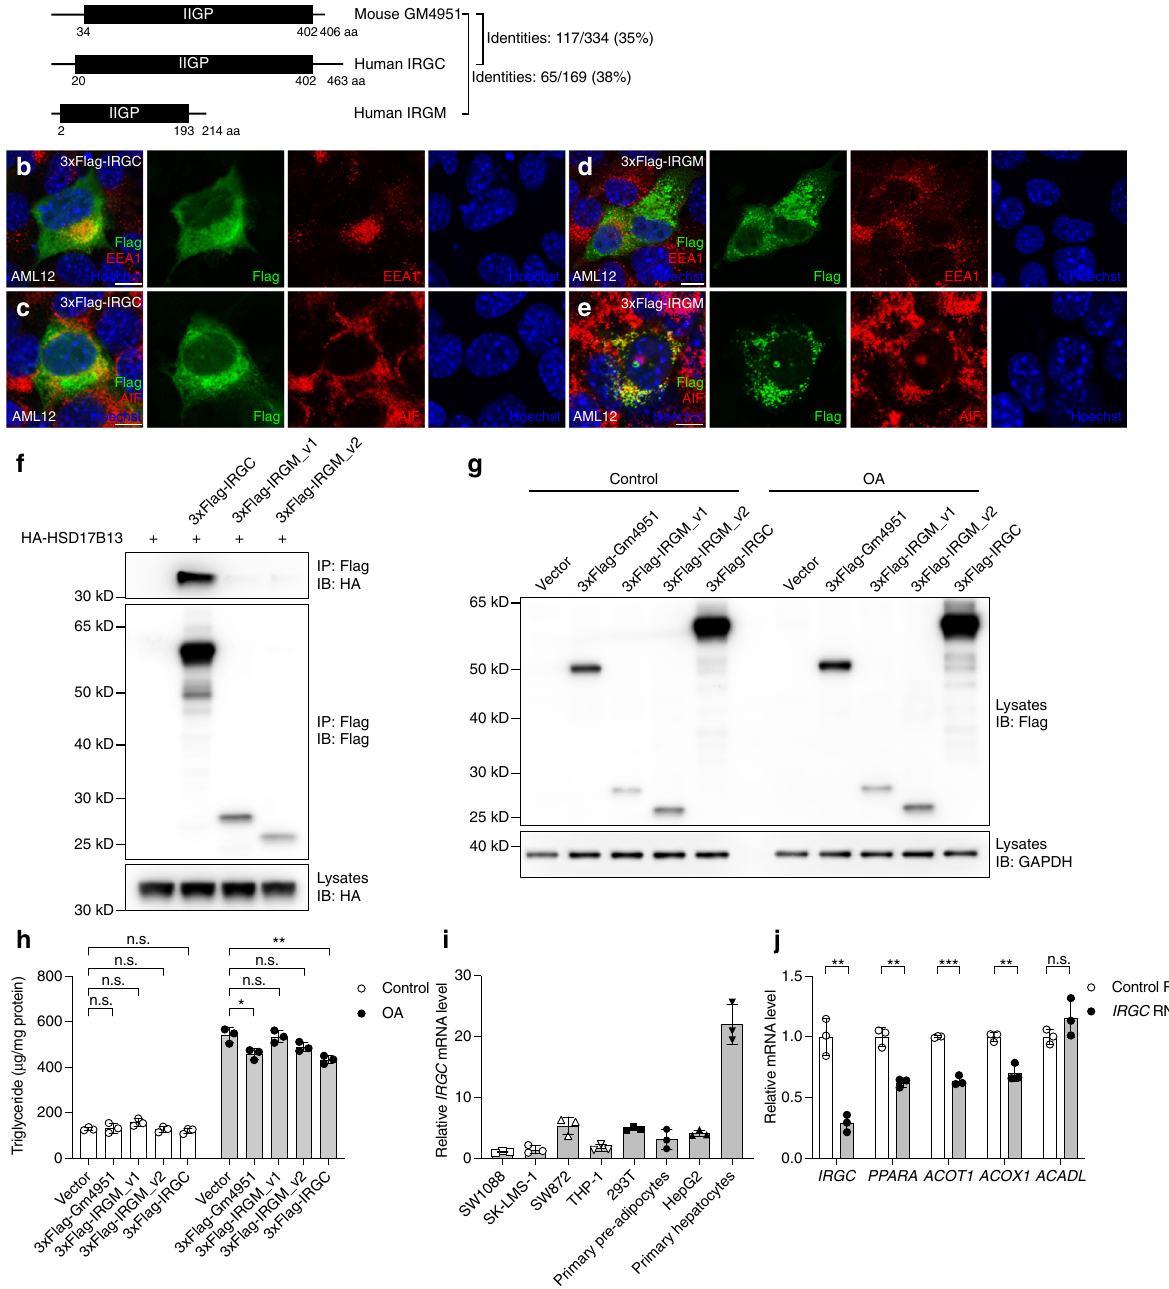
Fig. 8 Identi fi cation of potential human homologs of mouse GM4951. a Protein domain diagrams of mouse GM4951 and human IRGC and IRGM. Locations of IIGP domains and amino acid identities across the full length of the proteins are indicated. b – e AML12 cells expressing 3xFlag-tagged IRGC or IRGM were immunostained with Flag antibody (green), Hoechst 33342 (blue) to visualize nuclei, and organelle markers (red): AIF (mitochondria) and EEA1 (endosome). (Scale bar: 10 μ m.) f Immunoblots of immunoprecipitates (top and middle) or lysates (bottom) of 293T cells expressing HA-tagged human HSD17B13 and 3xFlag-tagged human IRGC, IRGM_v1, and IRGM_v2. g , h Immunoblots of lysates ( g ) or triglyceride level in lysates ( n = 3 cultures per group) ( h ) of primary human hepatocytes expressing different IRG genes with or without 0.5 mM OA treatment for 24 h. i Relative mRNA level of IRGC from different human cell lines or human primary cells. Levels were normalized to ACTB mRNA and then to levels in SW1088 cells ( n = 3 cultures per group). j Relative mRNA level of IRGC and several lipid oxidation genes ( PPARA , ACOT1 , ACOX1 , and ACADL ) from primary human hepatocytes transfected with control siRNA or IRGC siRNA with 0.5 mM OA treatment for 24 h ( n = 3 cultures per group). Levels were normalized to ACTB mRNA and then to levels in control RNAi. Data points represent independent cultures. Data are presented as means ± SD. P values were determined by one-way ANOVA with Tukey ’ s multiple comparison test ( h ) or two-tailed Student ’ s t test ( j ). P values are denoted by * P < 0.05; ** P < 0.01; *** P < 0.001; ns, not signi fi cant with P > 0.05. The exact P values of statistically signi fi cant groups are: 0.0158 ( h , Vector vs 3xFlag-Gm4951 OA); 0.0026 ( h , Vector vs 3xFlag-IRGC); 0.0019 ( j , IRGC ); 0.0015 ( j , PPARA ); 0.0001 ( j , ACOT1 ); 0.0031 ( j , ACOX1 ). Data are representative of two independent experiments ( b – j